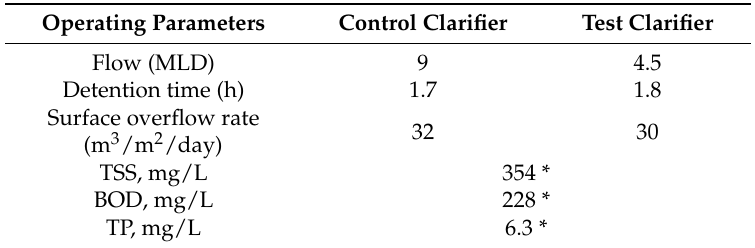
Table 1. Clarifier operating parameters and wastewater characteristics.